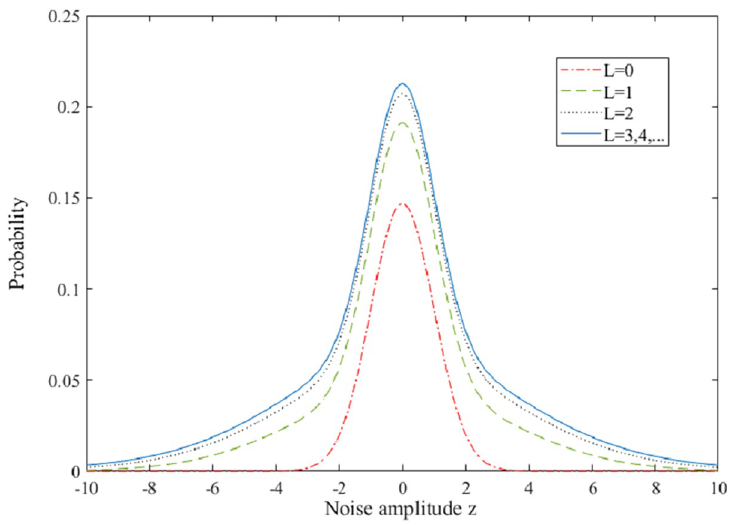
Fig 3. PDF of noise amplitude z for A = 1 and L = 0, 1, 2, ... .